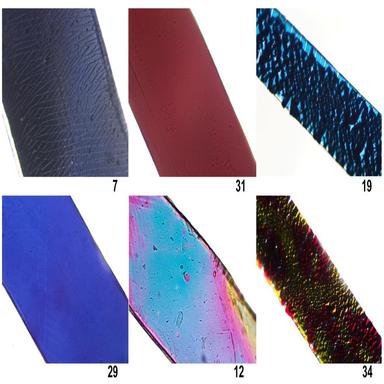
Images of selected so-called metallised fibres in the bright-field microscopy, at 200 × microscope magnification.